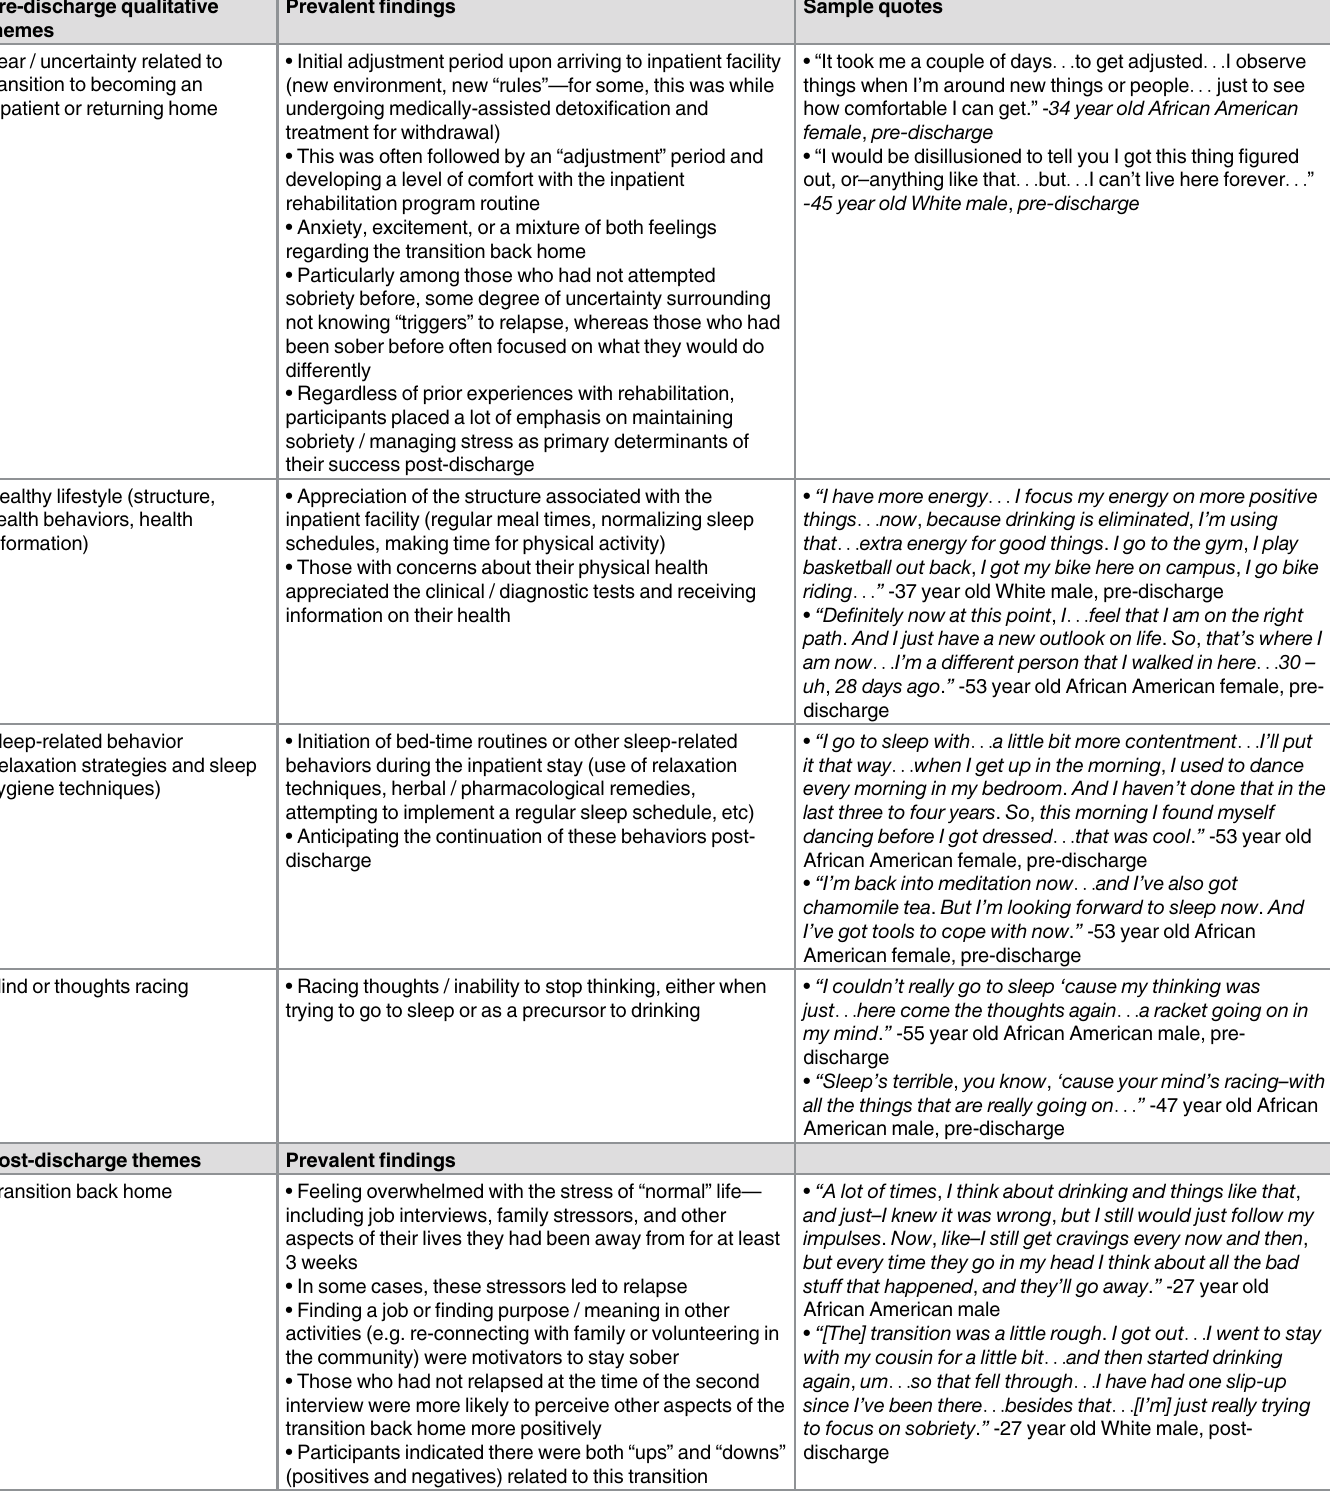
Table 4. Summary of key qualitative findings by time point and